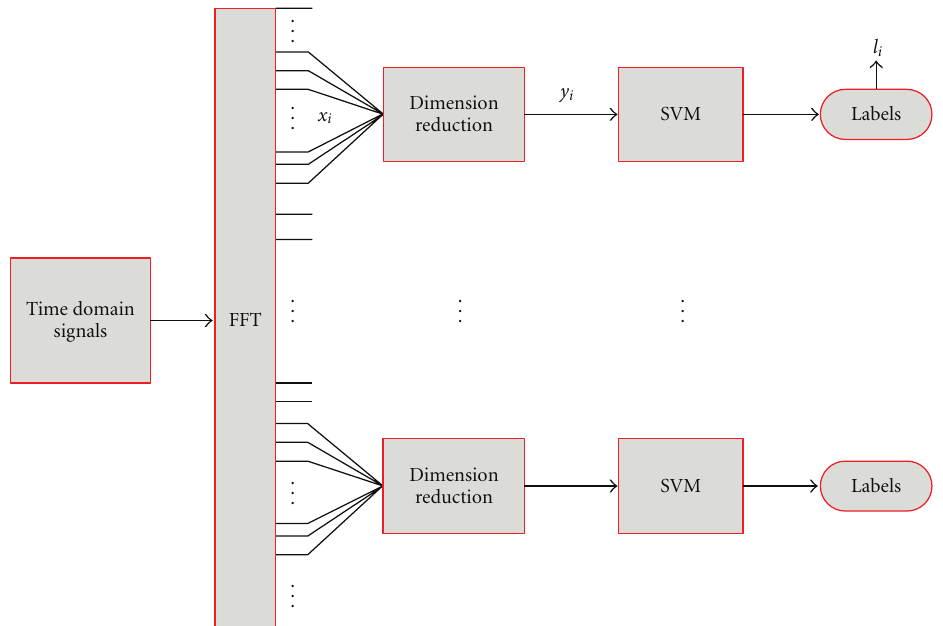
Figure 5: The flow chart of SVM combined with dimensionality reduction.